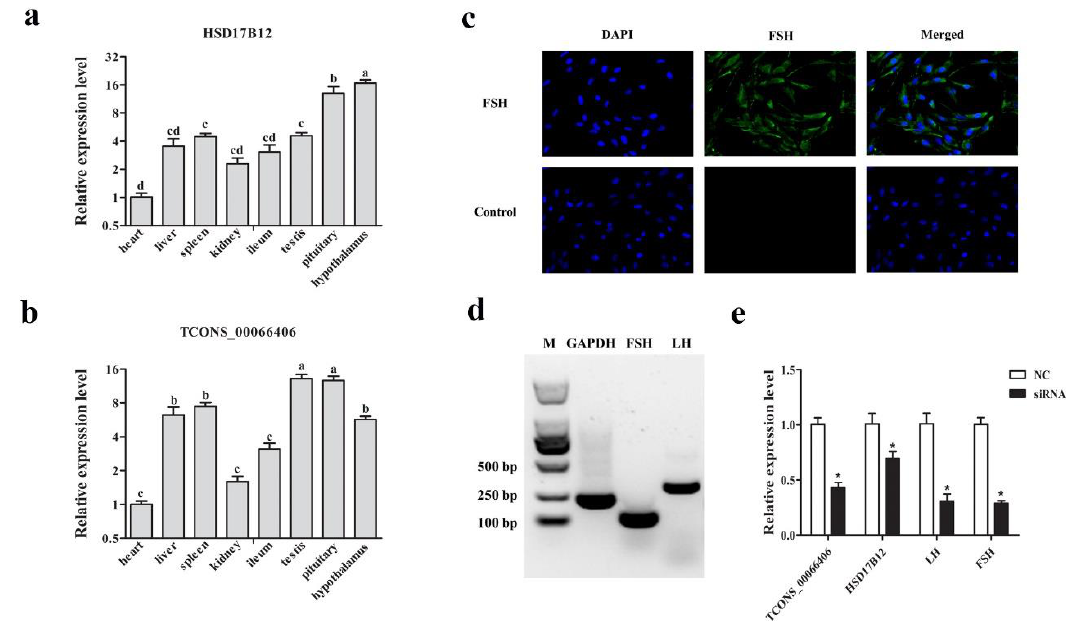
Figure 8. The validation of the interaction between lncRNA TCONS_00066406 and its targeted gene HSD17B12 , with ( a ) and ( b ) representing the expression levels of HSD17B12 and lncRNA TCONS_00066406 in different tissues, respectively. ( c ) The immunofluorescence staining of FSH in isolated cells. ( d ) The gel electrophoresis results of FSH and LH PCR amplification products. ( e ) The relative expression of lncRNA TCONS_00066406, HSD17B12, FSH and LH after sheep pituitary cell transfection using TCONS_00066406 siRNA. The qPCR results were expressed relative to the TM group as the mean values ± SEM and the relative expression levels were normalized to the expression levels of GAPDH . a, b and c: different letters denote statistically significant differences within each group; * denotes the significant difference between two groups, p < 0.05.